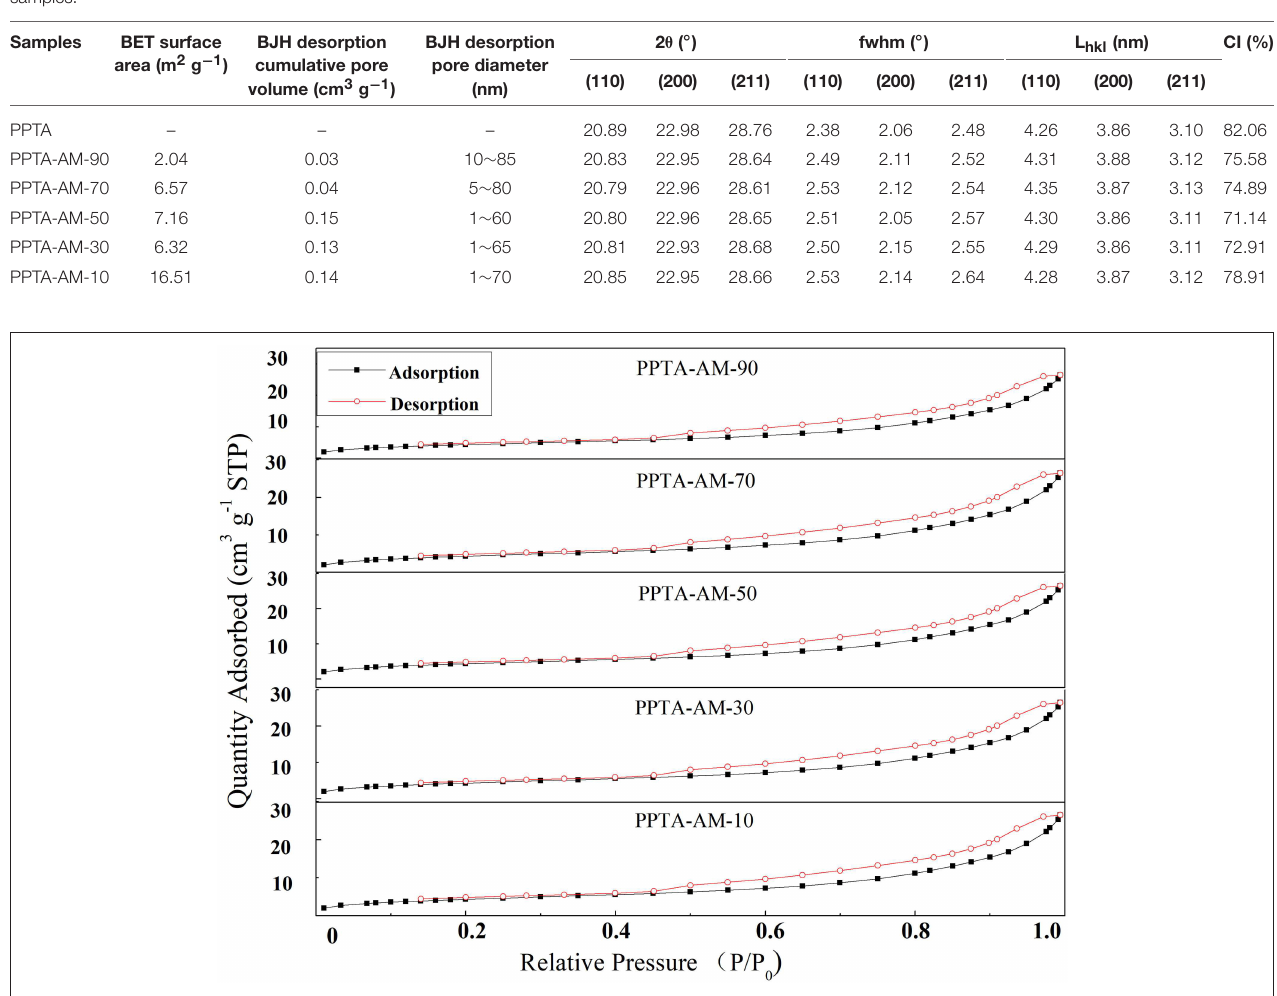
TABLE 2 | Formulations, element concentrations, parameters of porous structures and ratio of functional group to metal ionon the surfaces of PPTA and PPTA-AM samples. Samples